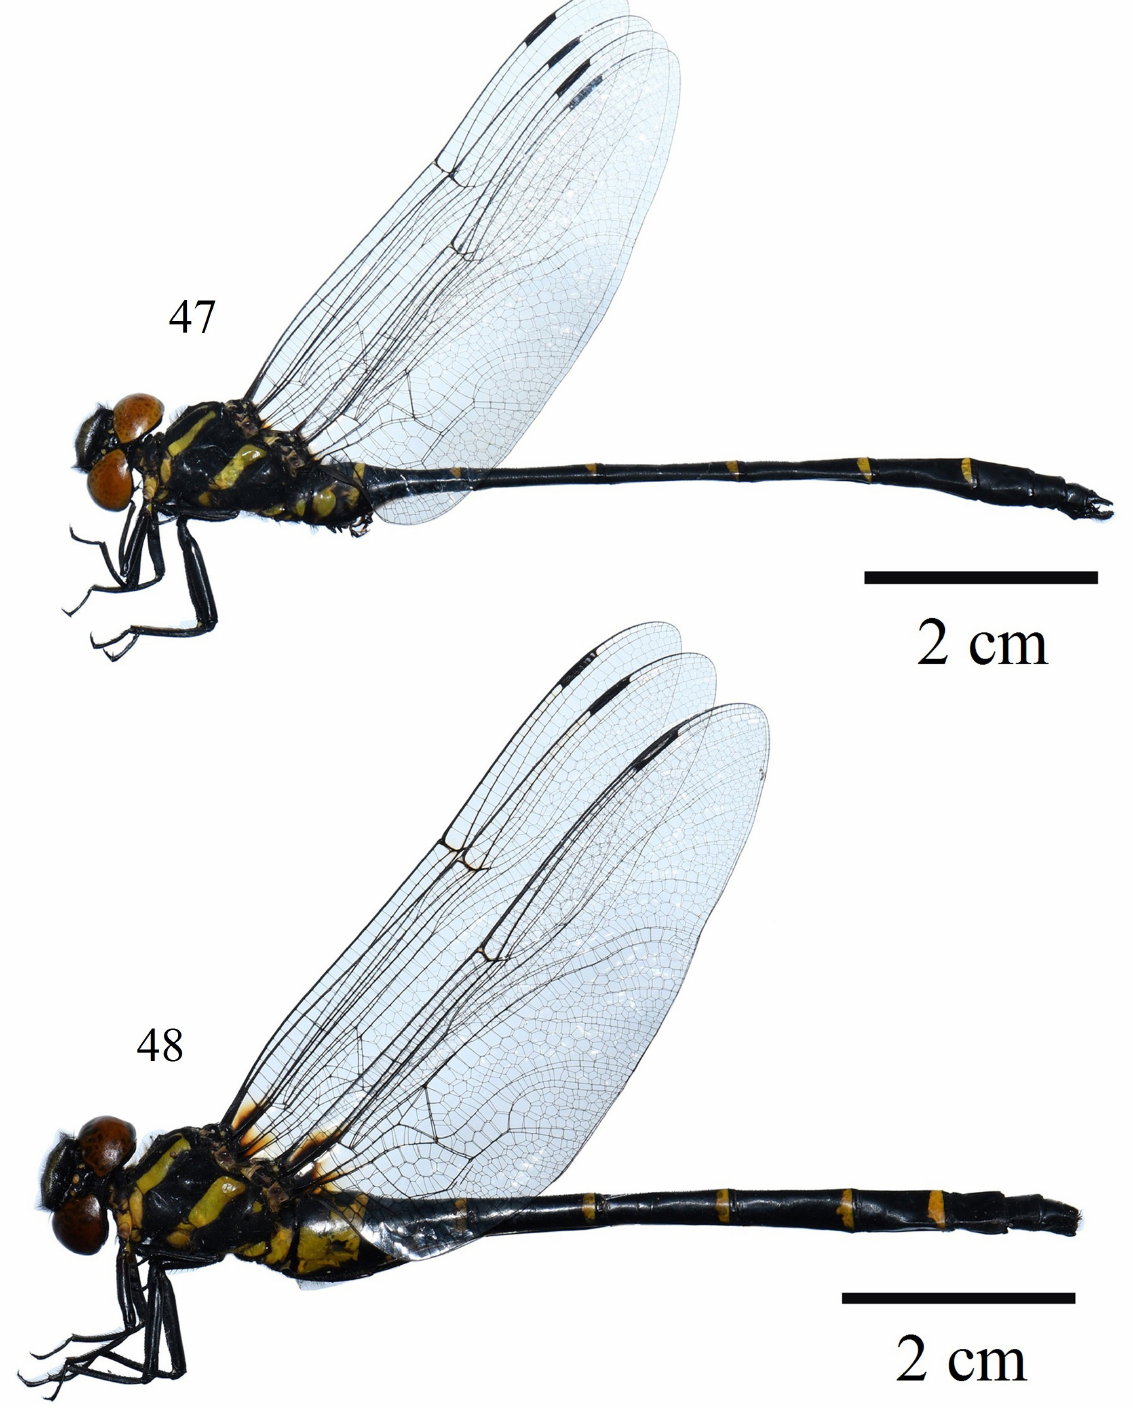
Figs 47–48. Habitus of Chlorogomphus gracilis Wilson & Reels, 2001. 47 . ♂ (ZCDTU 2019060501- ODO). 48 . ♀ (ZCDTU